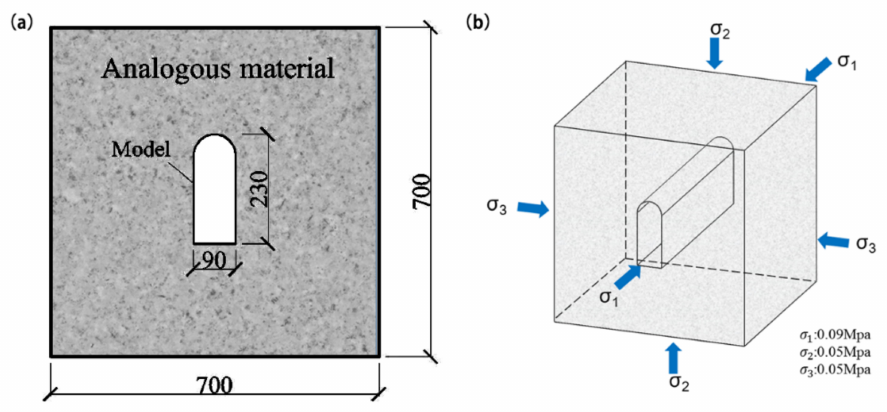
Figure 8. ( a ) Model dimensions of surrounding rock (Unit: mm); ( b ) geo-mechanical model test loading scheme.